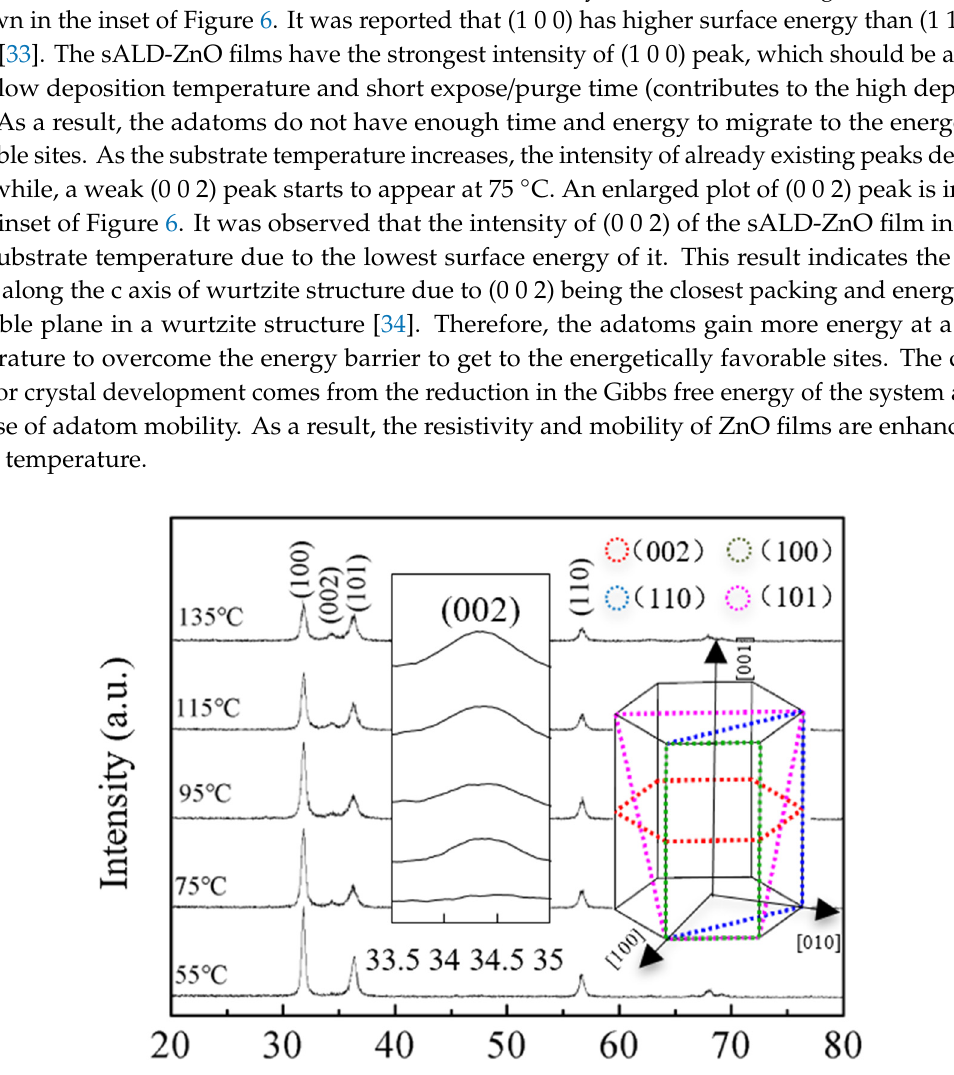
Figure 5. The variations of resistivity, carrier concentration ( N c ), and mobility ( μ ) for sALD-ZnO films with deposition temperatures.